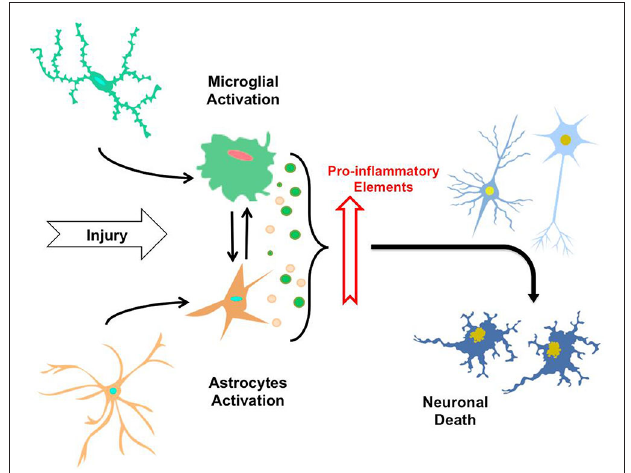
FIGURE 1 | The neuroinflammatory process . By sensing signals of damage or injury, astrocytes and microglia suffer a gradual activation process, leading to morphological changes and secretion of pro-inflammatory elements (i.e., cytokines, cytotoxic elements, ROS). Thus, the constant exposure of astrocytes and microglia to factor causing injuries and secretion of these elements induce mutual activation of microglial cells and astrocytes, along with neuroinflammatory process that eventually trigger neuronal